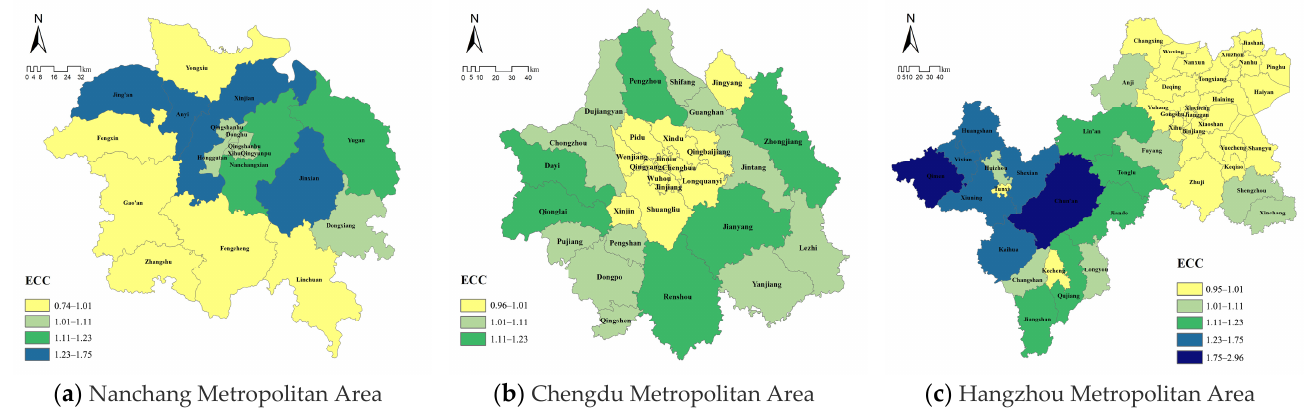
Figure 5. Economic contribution coefficients of three metropolitan areas.